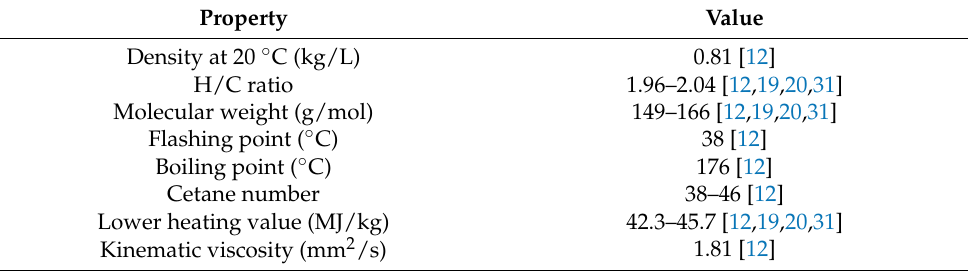
Table 2. Main physical–chemical properties of RP-3.